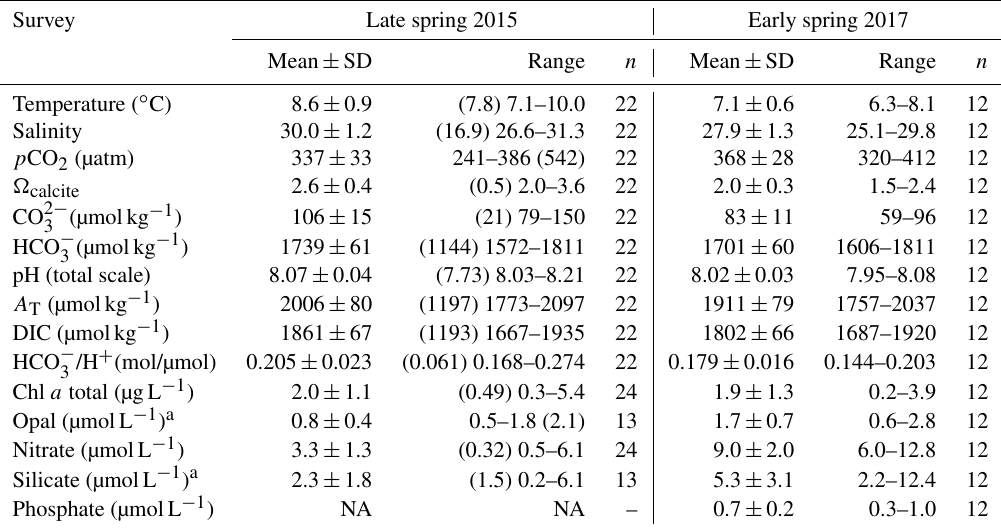
Table 2. Physical and chemical conditions and photosynthetic and silicified biomass proxies in the surface waters ( < 5m) of southern Patagonia fjords. Mean, standard deviation (SD), and range of each variable and number of samples for late spring 2015 and early spring 2017 are shown. Only values matching planktonic samples discussed in the text are included, except for chlorophyll a (chl a ), opal, nitrate, and silicate 2015 for which values are between 3–28km decoupled from biological sampling. The mean and SD do not include the Skyring Sound 2015 station as it shows extreme values for all variables (see Table S1). However, the values from that sample are shown in parentheses for comparison. NA: no available data.